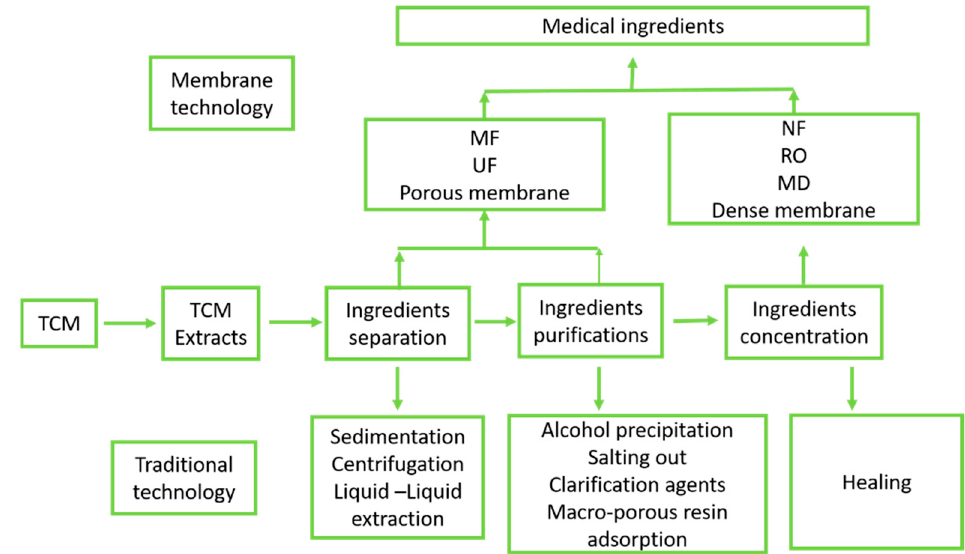
Figure 5. General technological procedure of TCM preparation.